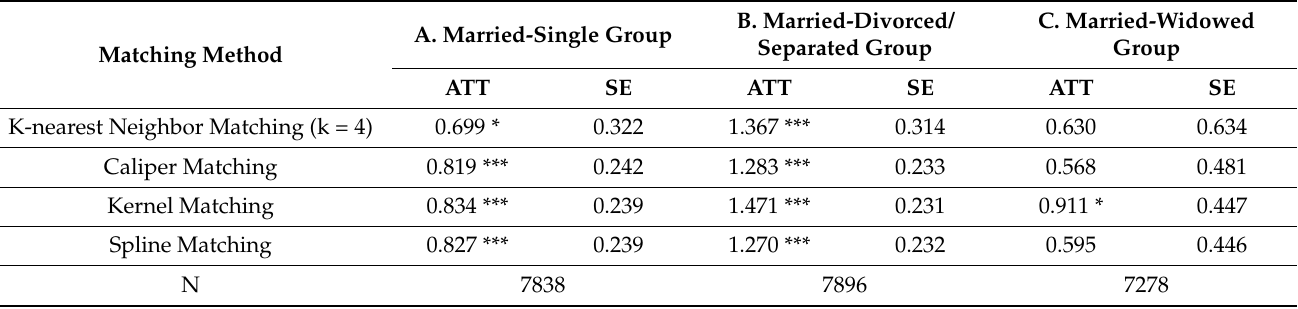
Table 7. Estimated average treatment effects on CESD-10 score changes in parents. (estimation of propensity score with Probit